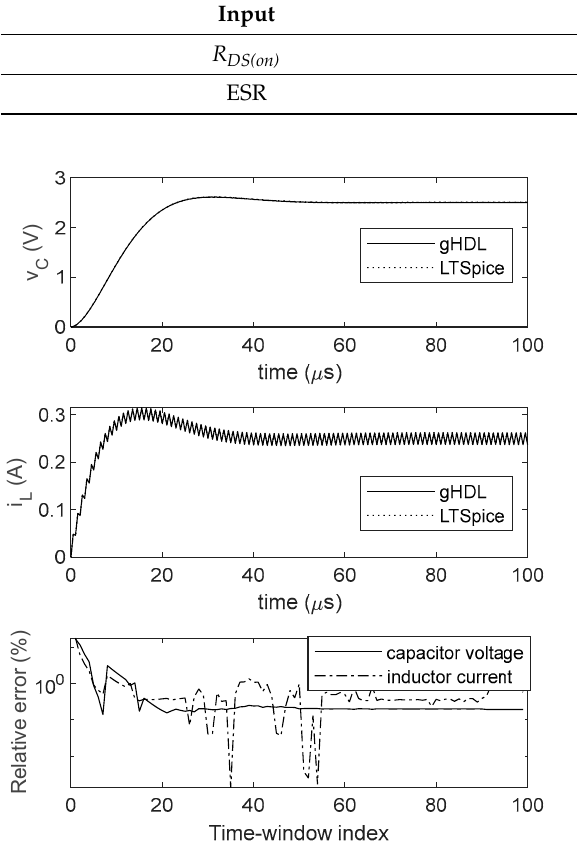
Table 2. Parasitic component values.